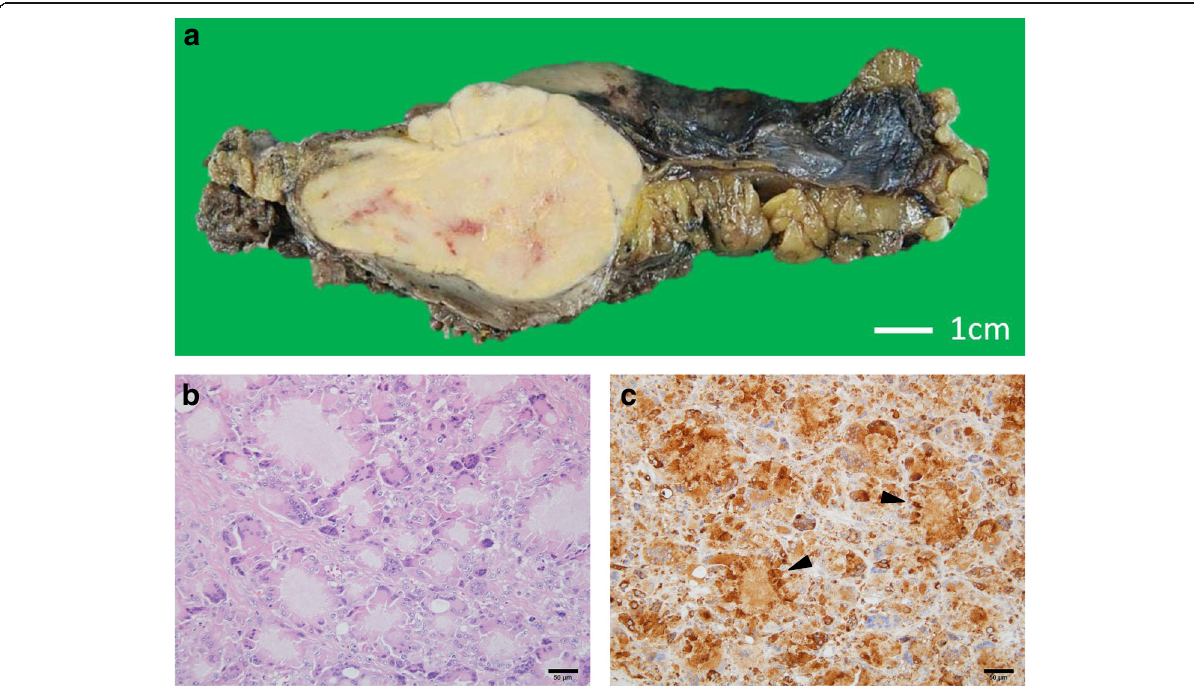
Fig. 6 a Macroscopic findings of the cut surface of the tumoral mass showing a lobulated, firm, yellowish-white portion. b Histological findings. Hematoxylin and eosin staining showing a foreign-body granuloma consisting of string-like crystals and a foreign-body giant cell. Many tiny granulomas with central bluish-pink crystals surrounded by macrophages are evident. Bar 50 μ m. c Immunohistological staining using anti-CD68 antibody (clone KP1) against CD68, a known macrophage surface marker, was positive in cells surrounding phosphoglyceride crystals (arrowhead) bar 50 μ m.